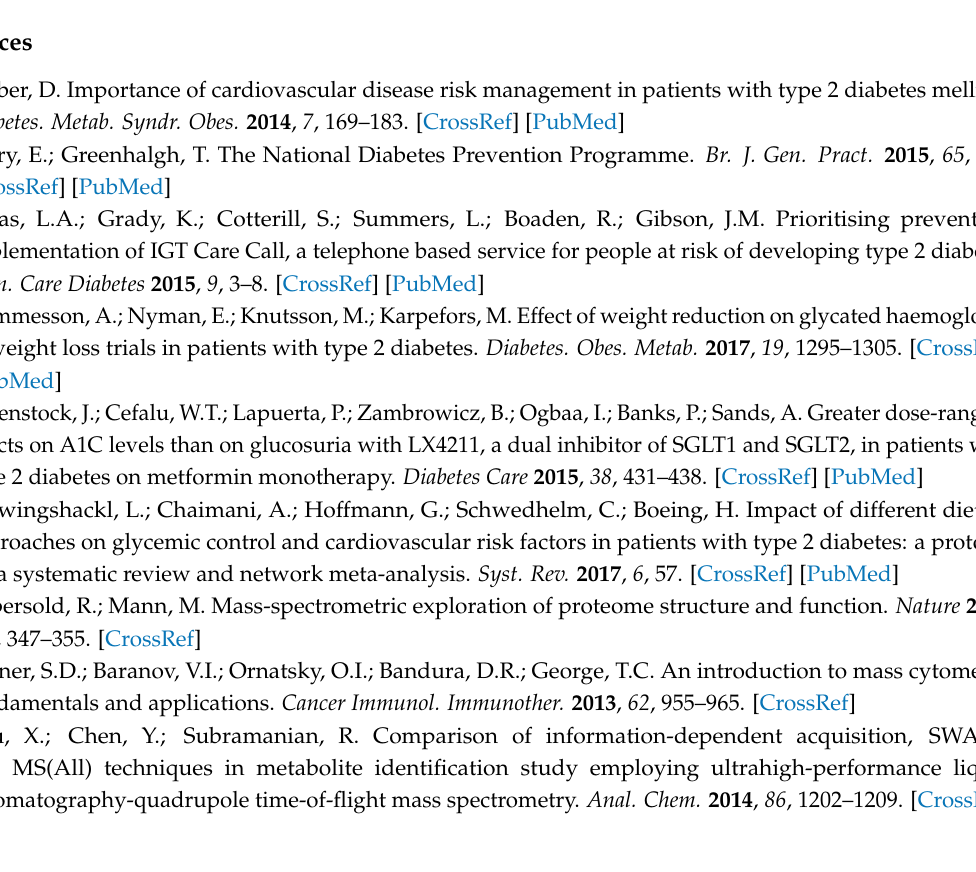
Table S1: List of the proteins analysed in the PCA discriminating future weight loss vs no significant weight loss included IGF-II and Vitamin D binding